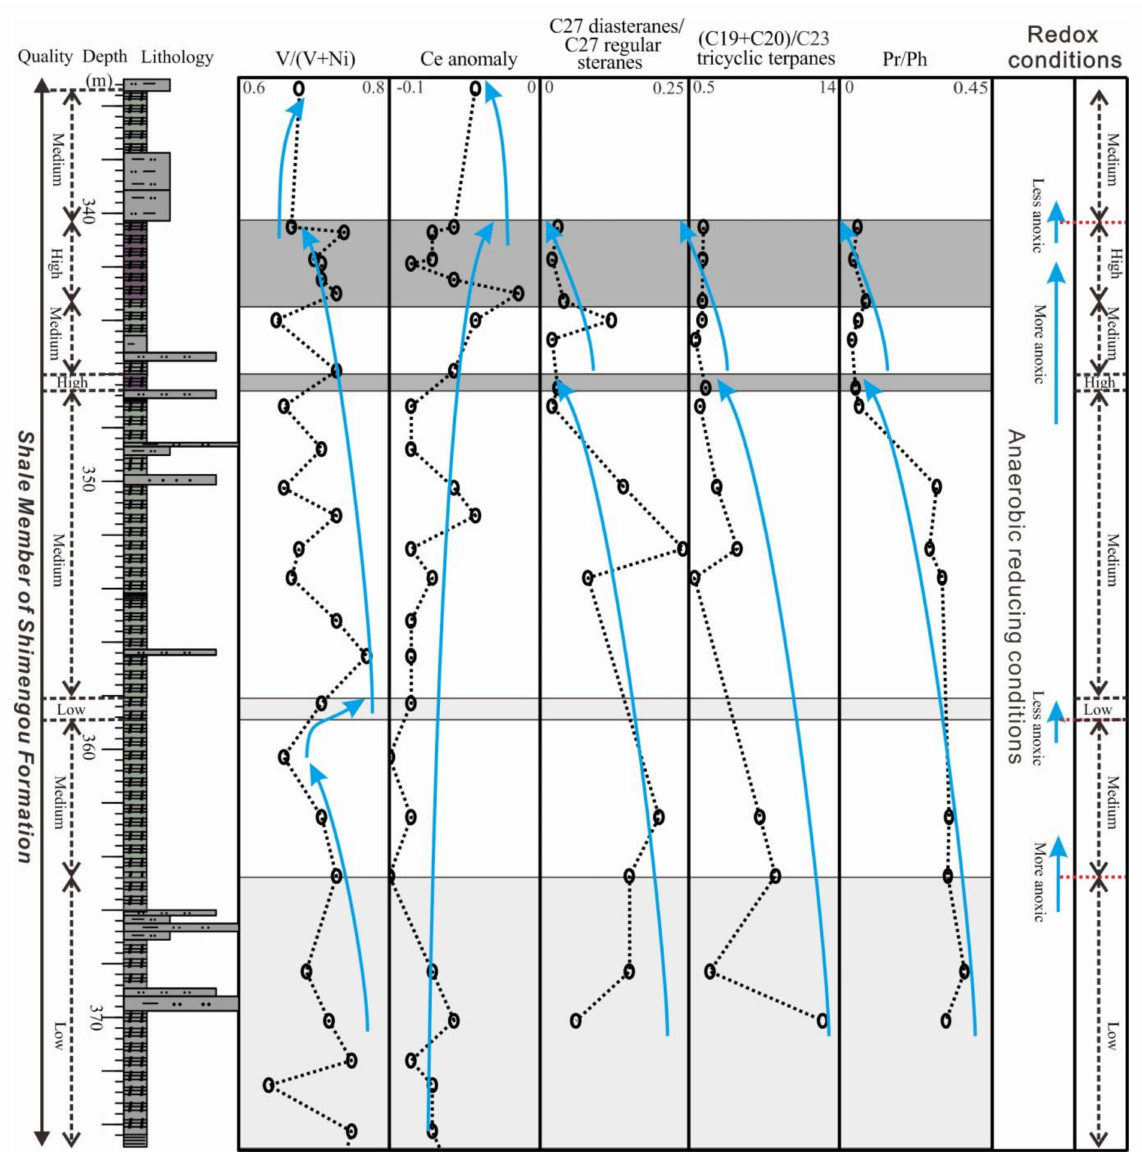
Figure 7. Vertical distribution of redox conditions and lithology in different-quality oil shales in the Shale Member of the Shimengou Formation (See Figure 2 for a legend; see Table 4 for ratio